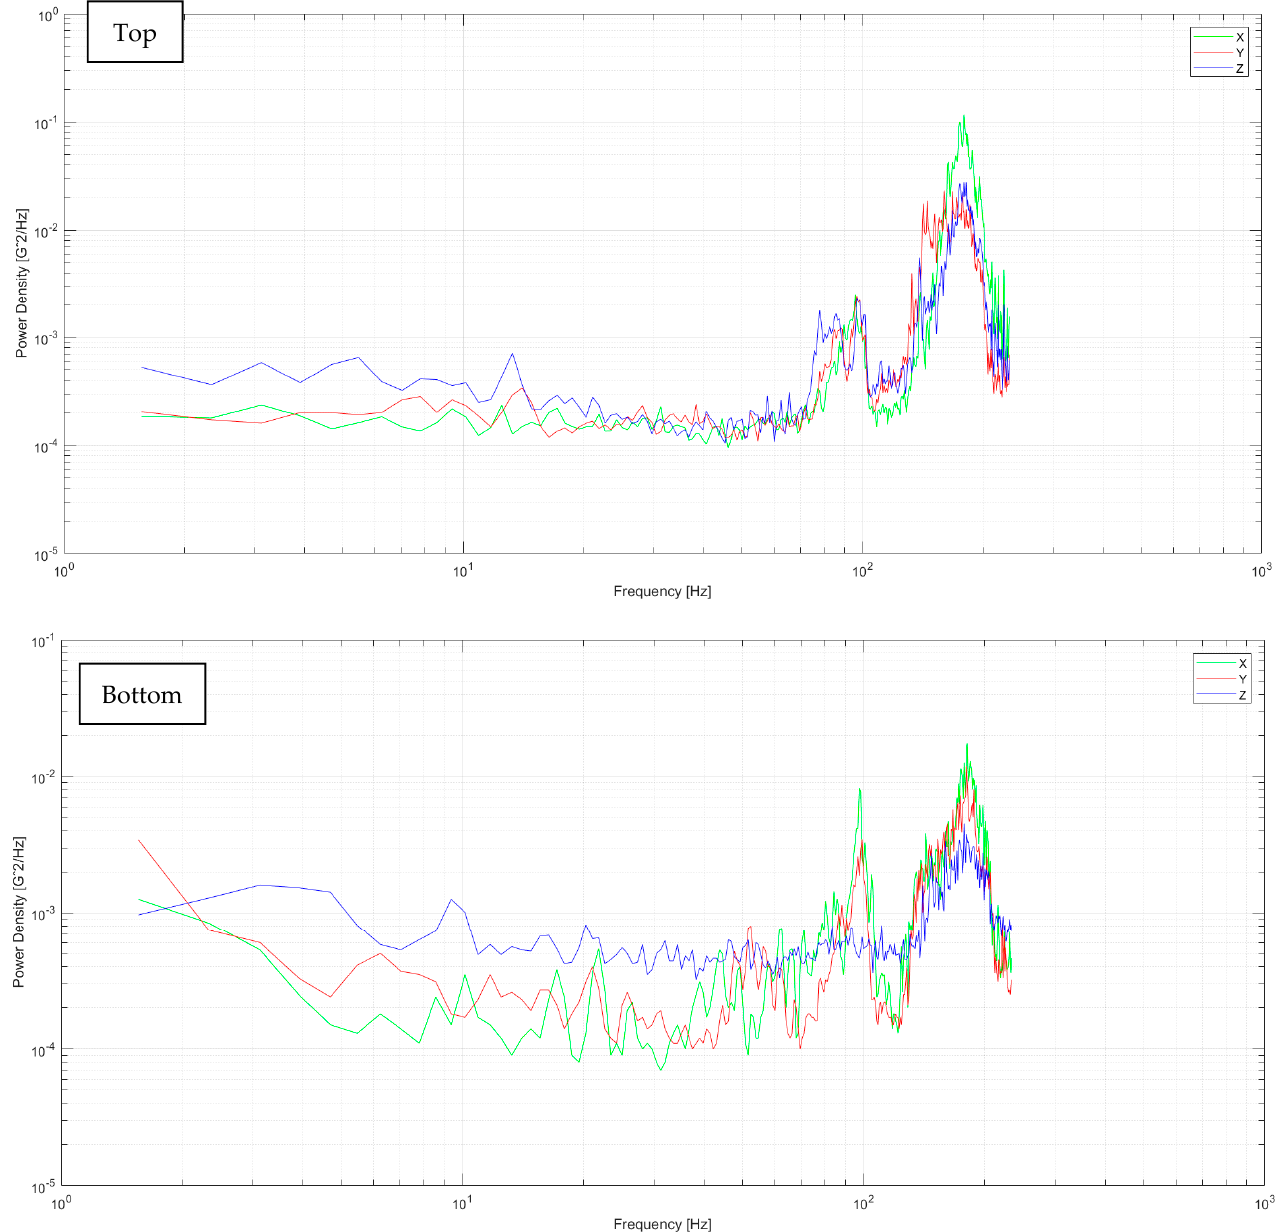
Figure 6. Consolidated PSD profiles of the top and bottom part of the DJI Matrice 600 Pro.